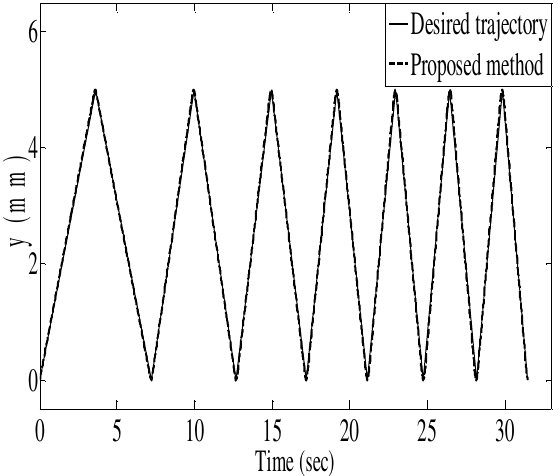
Fig. 11. Trajectory of y-component with decreasing segment